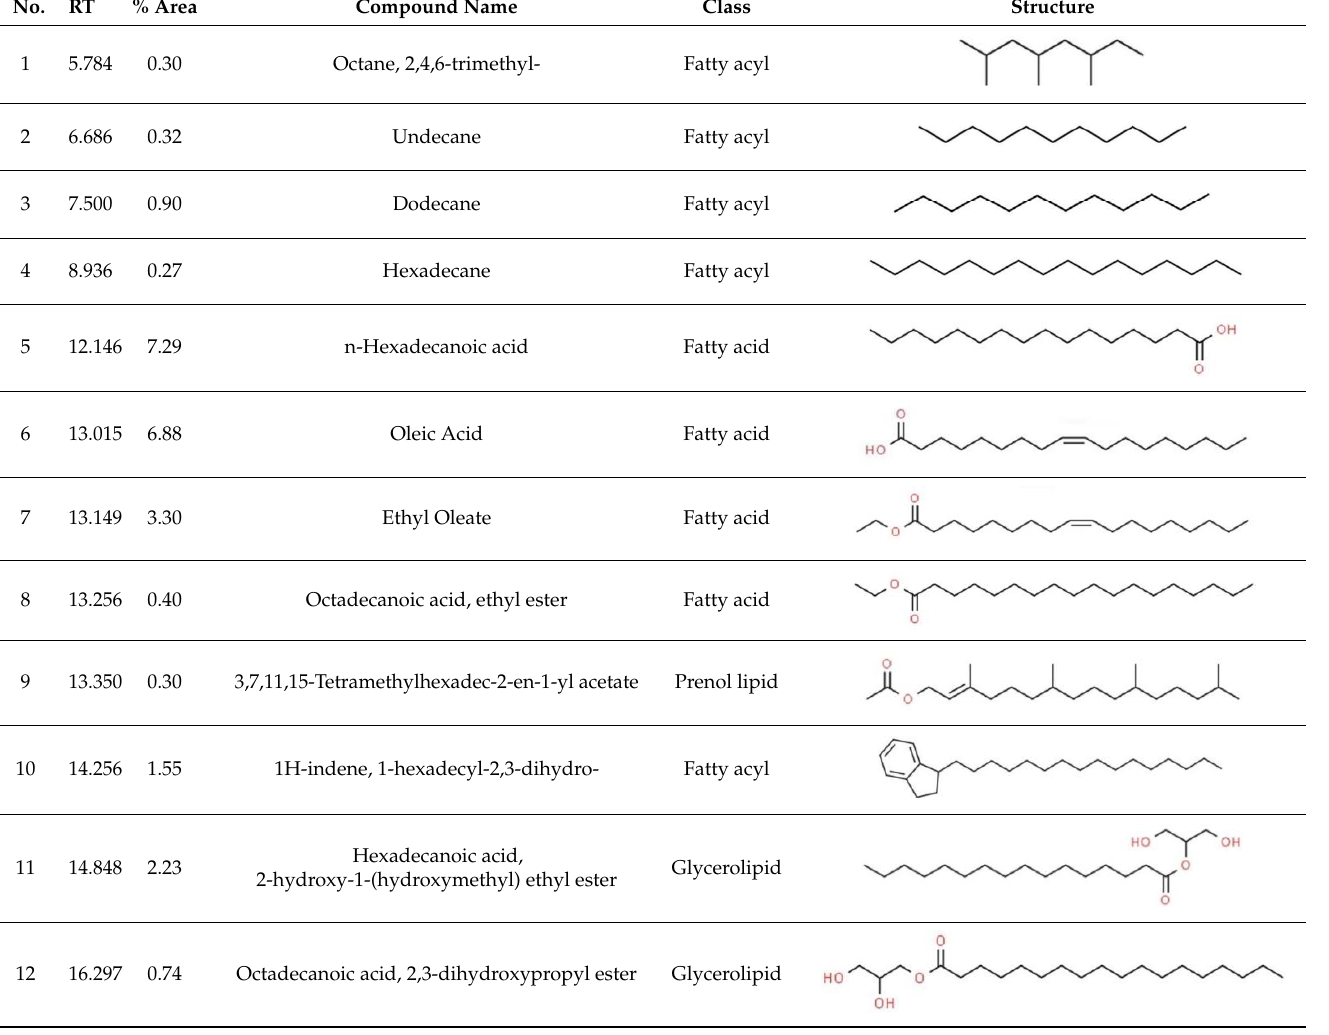
Table 2. Major constituents in the crude biosurfactant of L. plantarum using GC–MS.